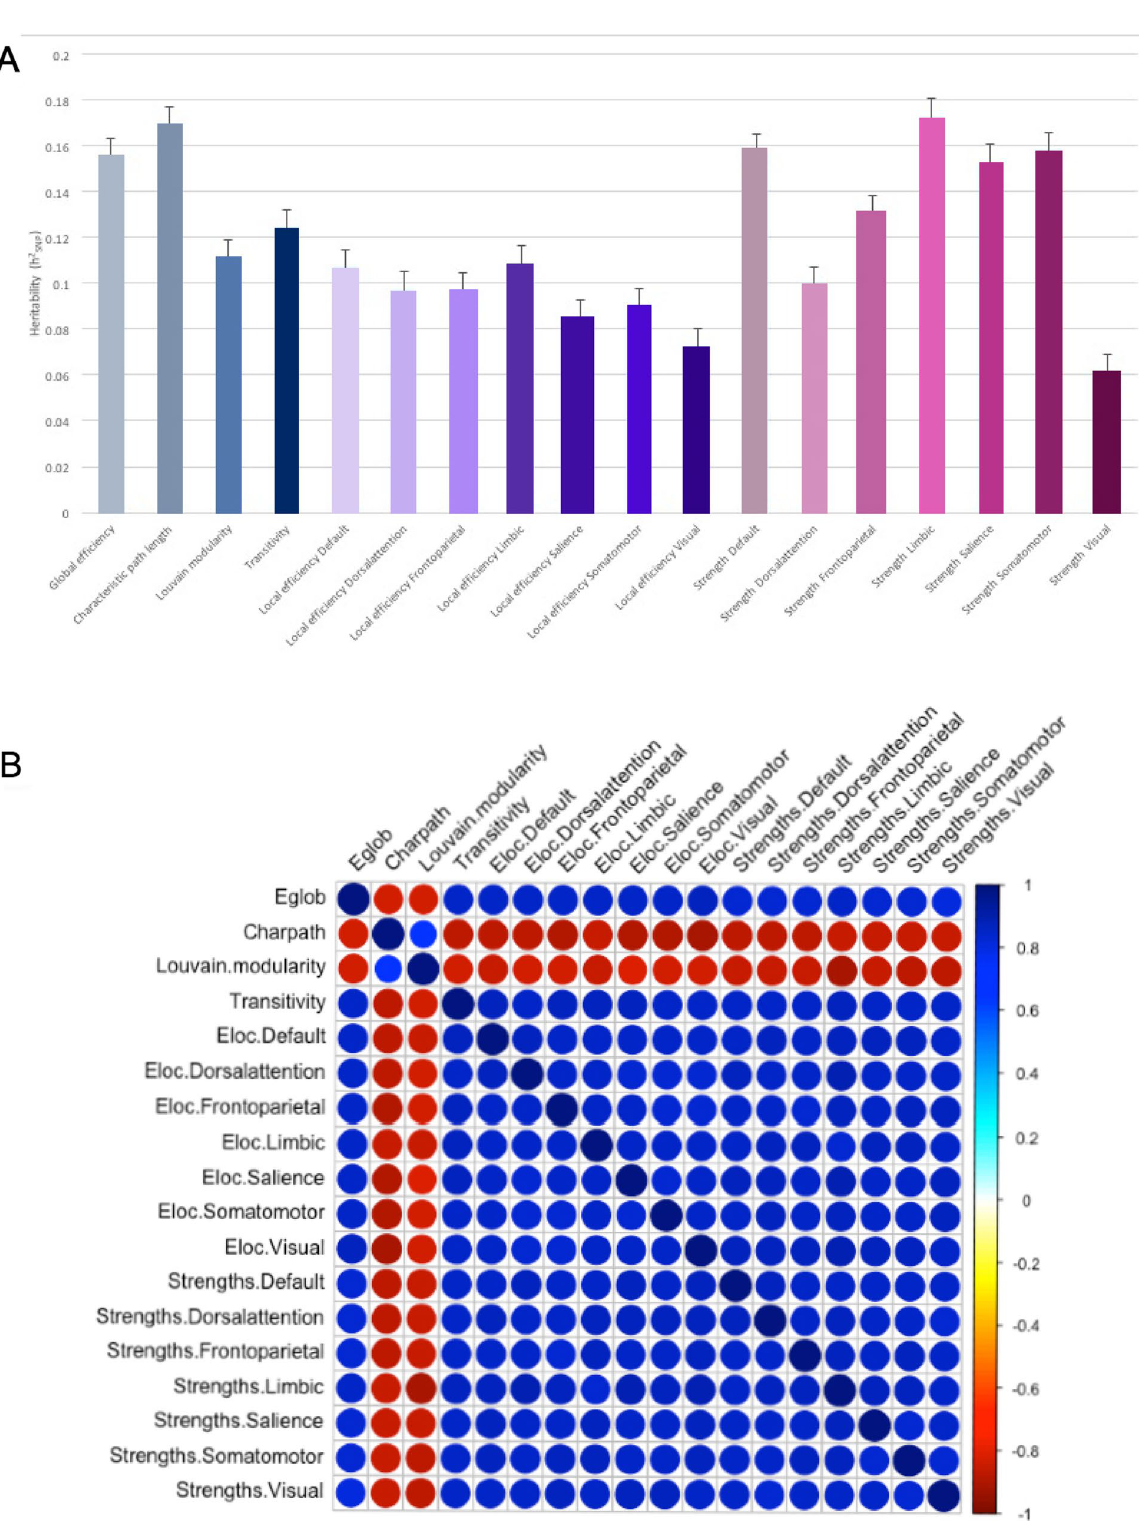
Figure 2. Genetic and environmental correlations between the 18 weighted graph theory measures. ( A ) represents the heritability estimates for each of the graph theory measures. Gray represents the network integration as characterized by global efficiency and characteristic path length; blue represents network segregation as characterized by Louvain modularity and transitivity; purple represents networks of local efficiency; and pink represents strength of the networks. ( B ) Genetic correlations were estimated using LDSC (https:// github. com/ bulik/ ldsc). Strong genetic and environmental correlations between the network measures were observed (see Supplementary Table 4 for more details). Abbreviations: Eglob, global efficiency; Charpath, characteristic path length; Eloc, local